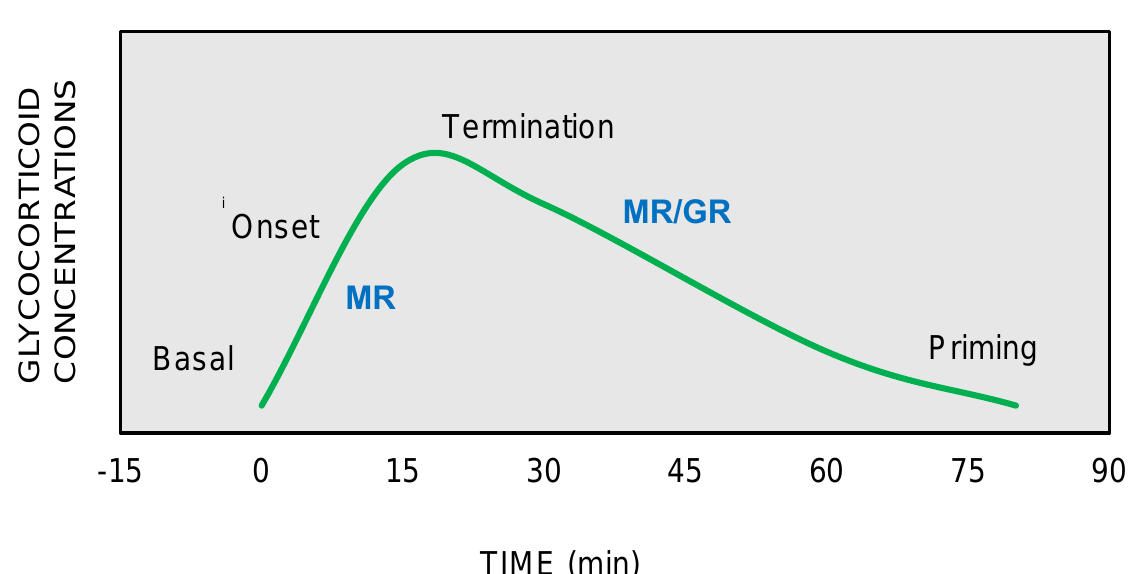
Figure 2. The stress response can be divided into four phases: ( 1 ) Basal: intracellular MRs are occupied with low concentrations of glucocorticoids (GCs). ( 2 ) Onset: GCs secretion from the adrenal cortex in response to a stressful event. GCs bind to MRs, which are progressively activated as the concentrations of GCs increase ( 3 ) Termination: GRs are activated and mediate the termination of stress response by exerting negative feedback at the hypothalamic and anterior pituitary level ( 4 ) Priming: Stressful experiences will be stored through GRs action in hippocampus and prefrontal context for future use.